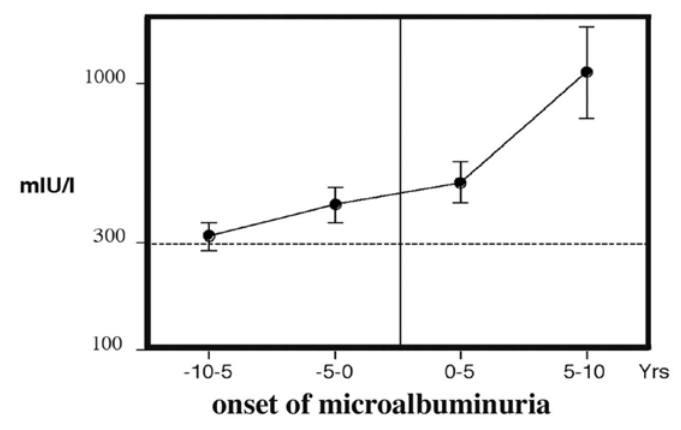
FIGURE 4. Plasma prorenin (log scale, y axis) in type I diabetic patients before and after the development of microalbuminuria. Adapted from Allen et